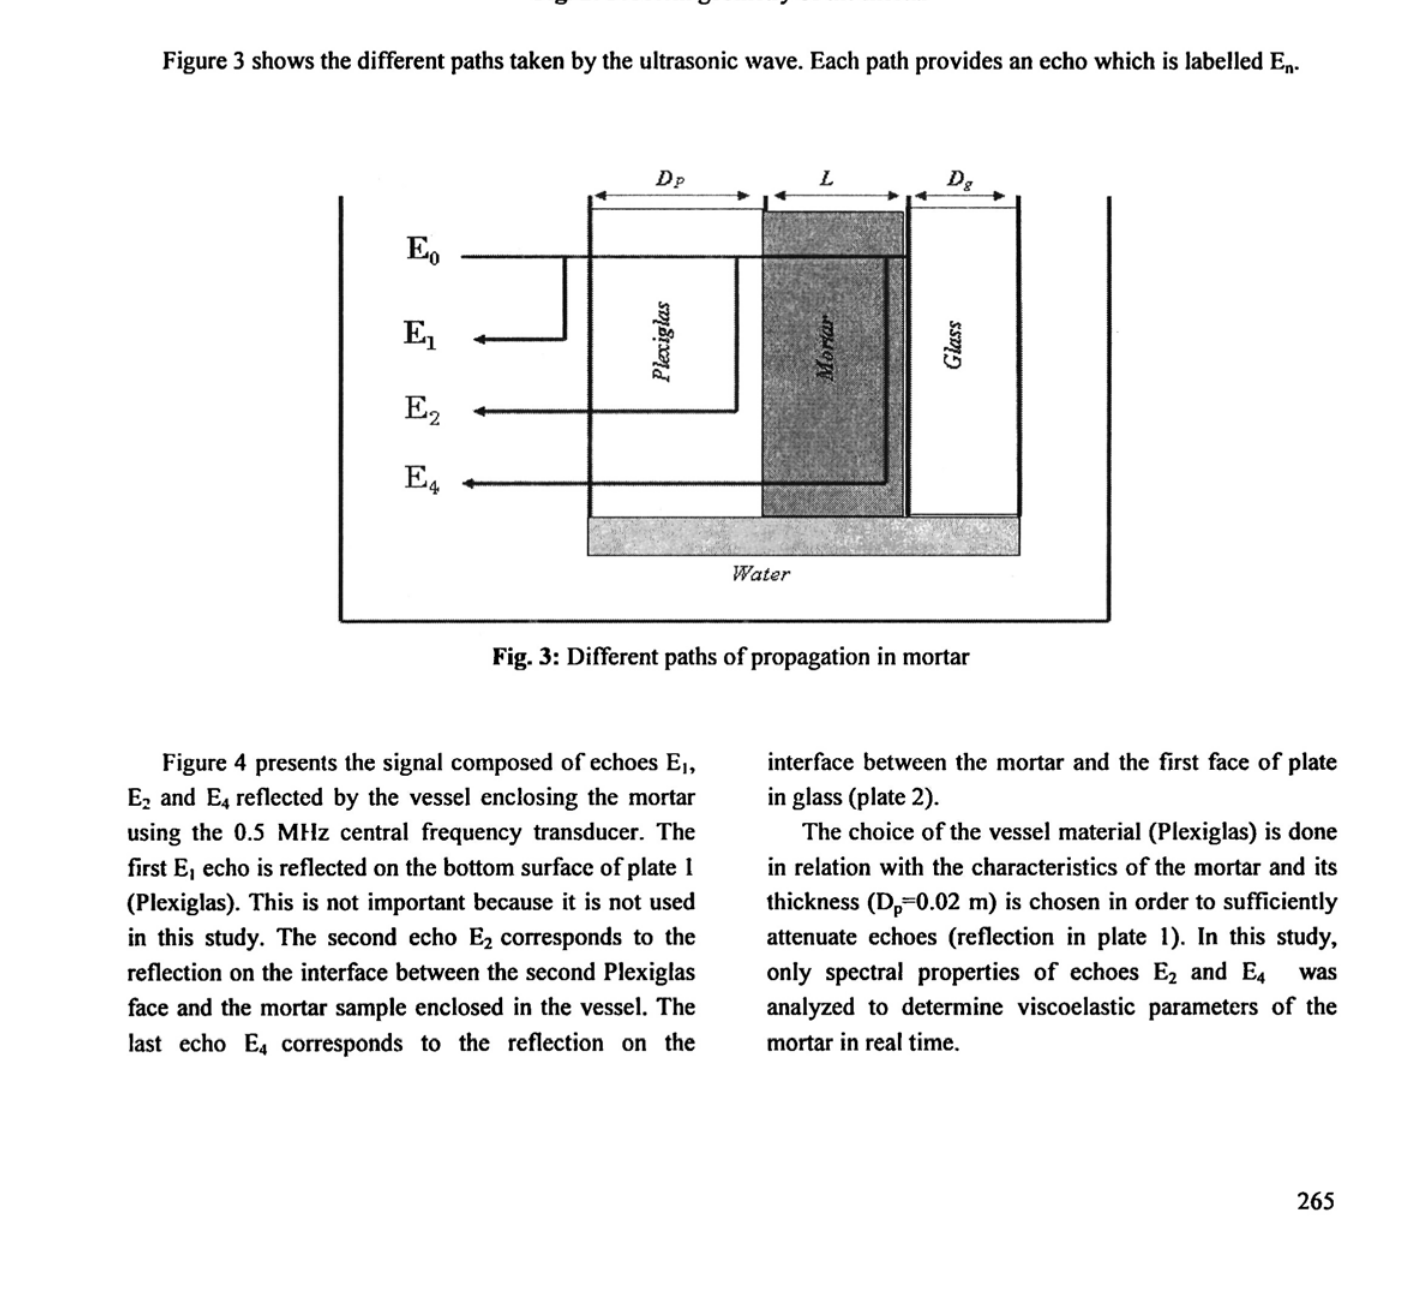
Fig. 2: Problem geometry of the mortar